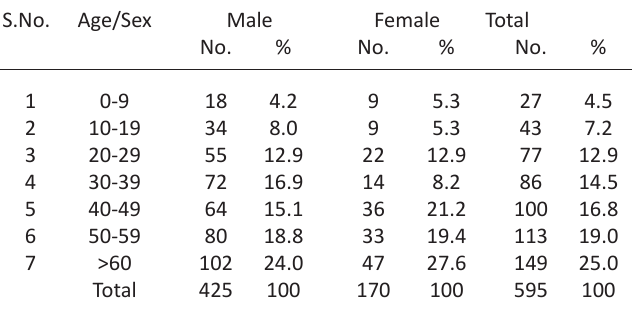
Table 1. Age-Sex distribution